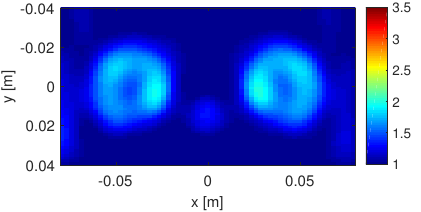
( e ) Reconstruction using the omnidirectional incident field for the circular sector measurement domain for the smaller imaging domain